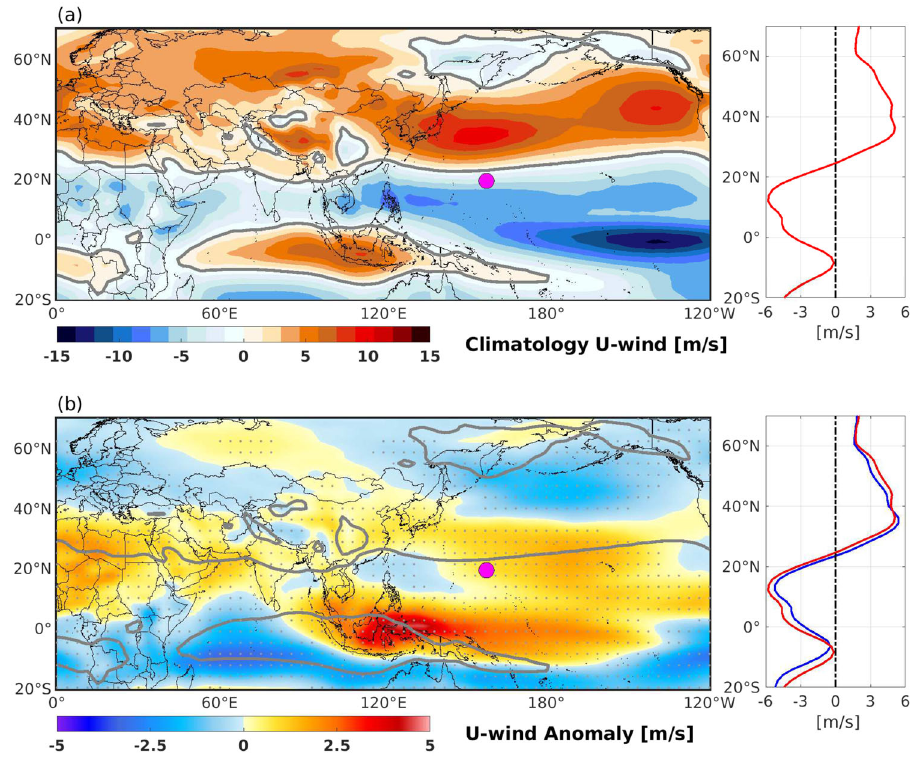
Fig. 4 Climatology and anomaly of zonal wind at 850 hPa pressure level during October to March. a Climatology zonal wind (u-component) based on the last 100 years of the AWI-ESM 568 ppmv CO 2 experiment. Positive values represent westerly wind, and negative values represent easterly wind. The right panel shows the mean zonal wind in this experiment. b Zonal wind anomaly in the AWI-ESM 284 ppmv experiment with respect to the 568 ppmv CO 2 experiment (i.e., Exp284 – Exp568). The right panel shows the mean zonal wind in the Exp284 (blue line) and Exp568 (red line) experiments. An equatorward shift of the westerly jet can be identi fi ed in the low-CO 2 experiment. Gray contours represent zero-crossing of the climatology zonal wind from easterly to westerly. The gray stippling indicates areas where the anomalies are statistically signi fi cant (two tailed Student ’ s t -test). The pink circle indicates the location of crust CM3D18.